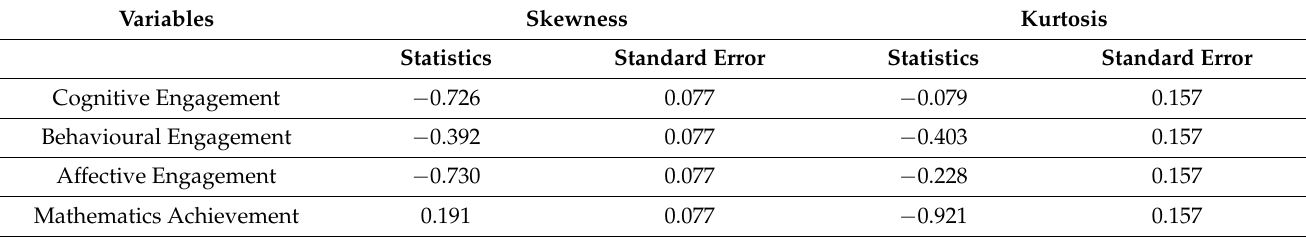
Table 5. Skewness and kurtosis values of the study variables ( n = 1000).